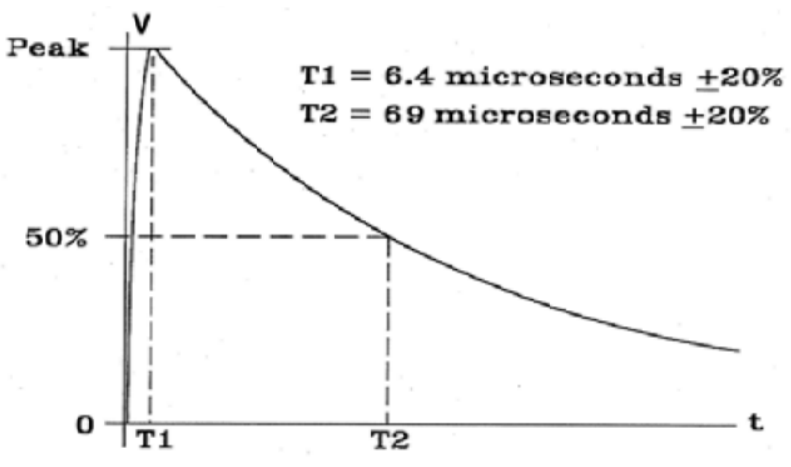
Figure 2. Idealized WF4 voltage waveform (6.4/69 µs) [9].